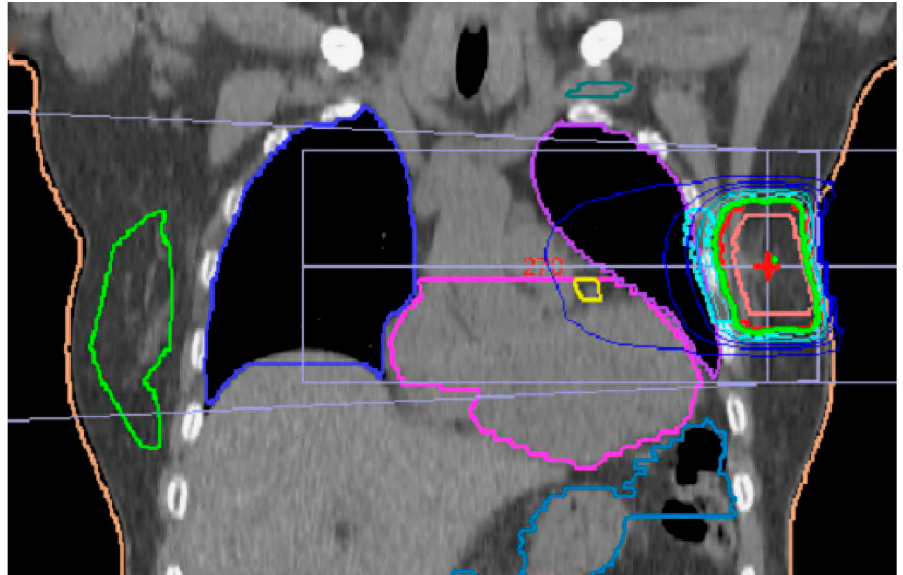
Figure 1. On average, 21% of the breast were irradiated by 90% of prescribed dose. Green isodose represents 95%. Yellow mark is LAD (left anterior descending artery), which was contoured in all left-side patients. Teal mark is for brachial nerve plexus. Contralateral breast is marked green.